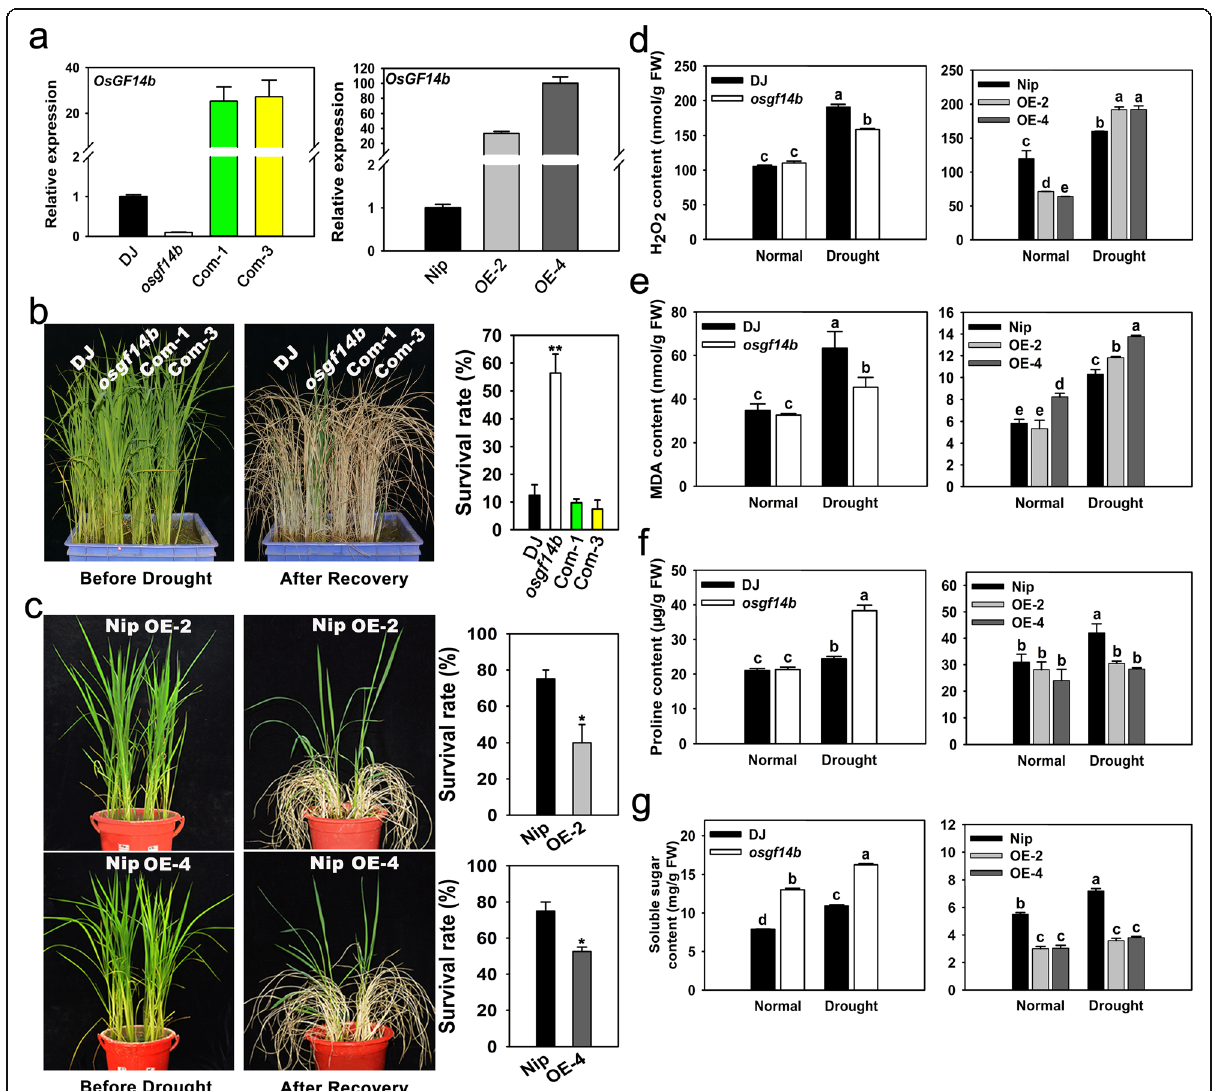
Fig. 1 Phenotypes of the osgf14b mutant, complementation and OsGF14b -OE lines under drought stress treatment at the seedling stage. a Expression analysis of OsGF14b in the osgf14b mutant, complementation and OsGF14b -OE lines. The rice Actin1 gene was used as the internal control. Error bars represent the SE of three biological replicates. b The osgf14b mutant showed increased drought resistance. The 5.5- to 6.5-leaf stage seedlings of DJ, osgf14b and complementation lines (about 20 seedlings for each genotype) were subjected to drought stress without water for 12 d and then recovered for 7 d. The seedlings with newly growing leaf blades were counted as surviving plants and the survival rates were recorded. Error bars represent the SE of three biological replicates (**, P <0.01, by Student ’ s t -test). c The OsGF14b -OE lines were more sensitive to drought stress treatment. The 5.5- to 6.5-leaf stage seedlings of Nip and OsGF14b -OE lines (about 10 seedlings for each genotype) were subjected to drought stress without water for 8 d and then recovered for 7 d. The seedlings with newly growing leaf blades were counted as surviving plants and the survival rates were recorded. Error bars represent the SE of three replicates (*, P <0.05, by Student ’ s t -test). d-g The H 2 O 2 , MDA, proline and soluble sugar content in the WT and transgenic plants (mutant and OE) under normal growth and drought stress conditions. Error bars represent the SE of three biological replicates. Statistical differences are labeled with different letters according to the LSD test ( P <0.05, one-way